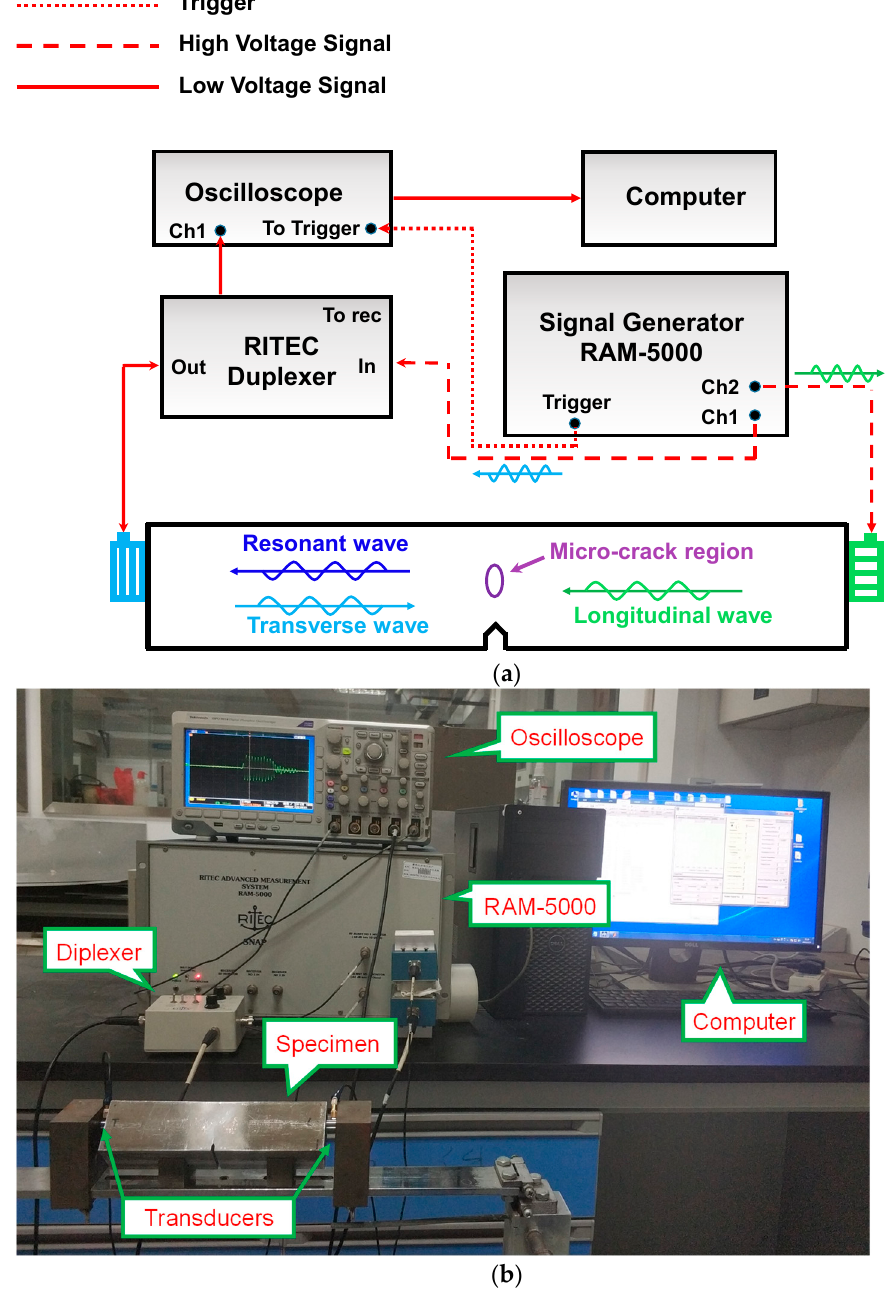
Figure 15. Experimental setup of the two-way collinear mixing method. ( a )The schematic diagram. ( b ) Experimental installation.